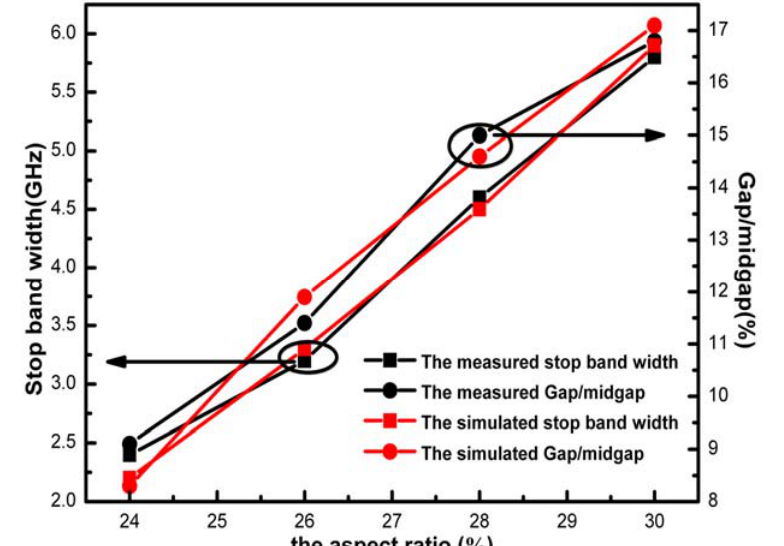
Figure 3. The relationship between the stop band properties and the aspect ratio of the PCs along the Г - Х <100>